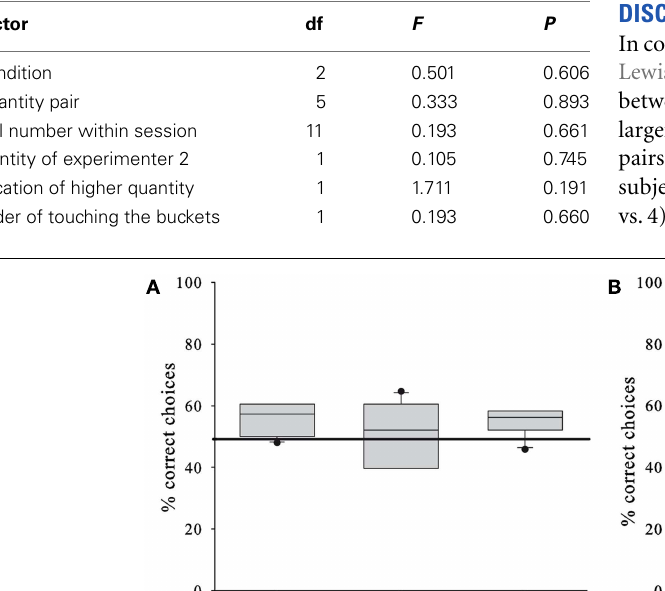
Table 2 | GLMM test statistics of the full model.